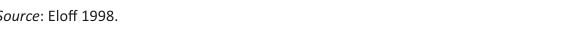
FIGURE 1: Structure of some secondary metabolites in the Rutaceae family.